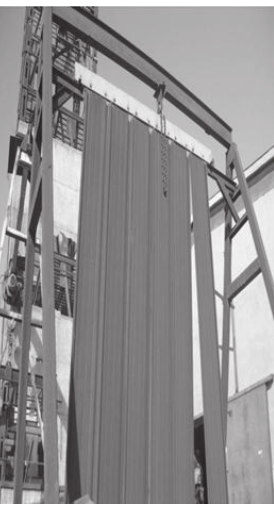
Figure 15: Test unit for measuring accelerations of collecting plate (JDEVS).